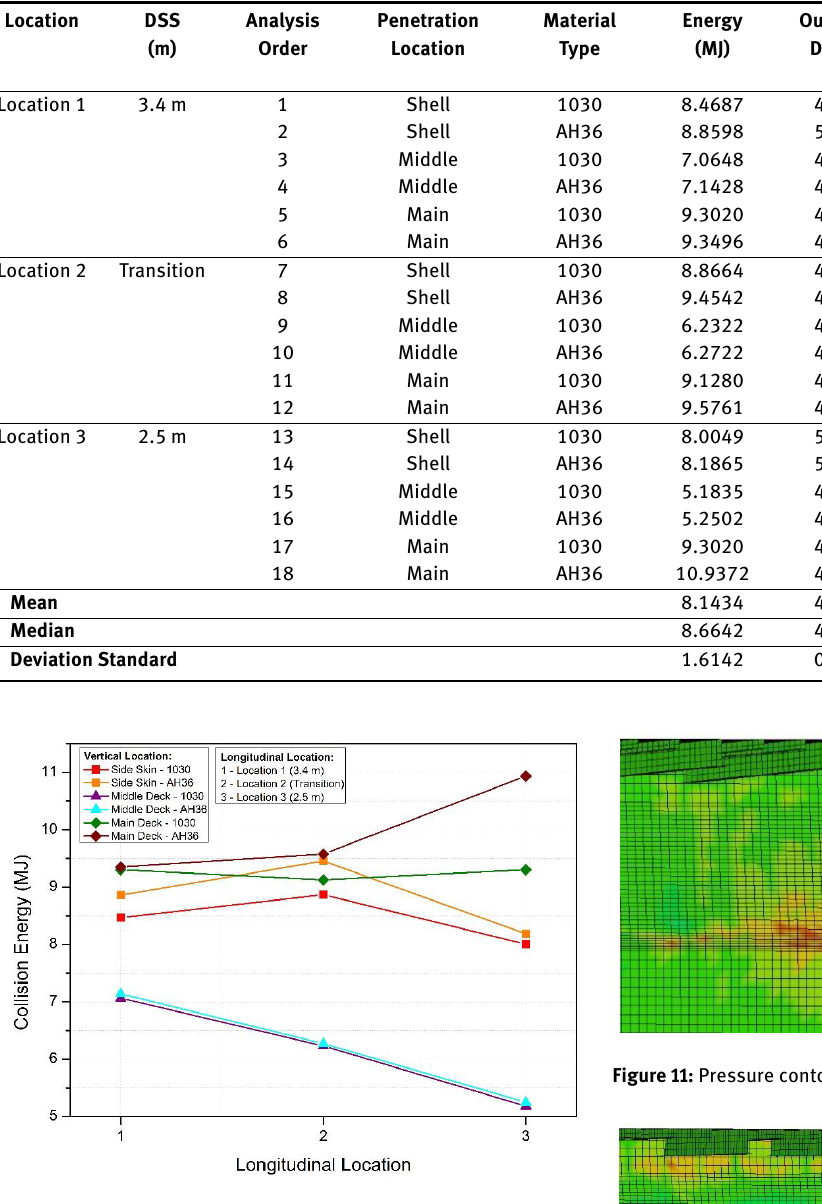
Figure 10: Material effect to energy magnitude after collision pro- cess.